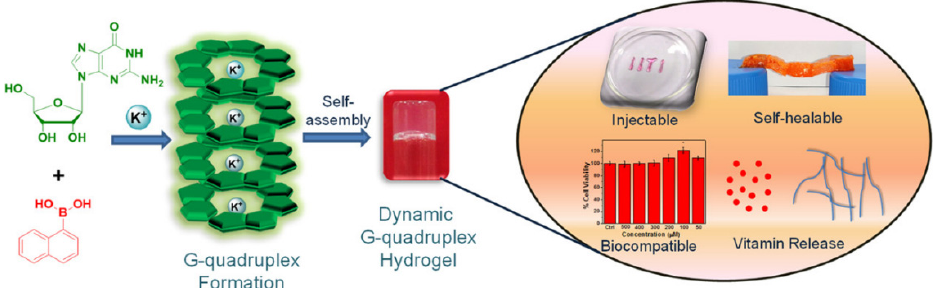
Figure 76. G-Quadruplex formation of a cytidine-based gelator and its features. Reprinted with permission from [138]. Copyright 2020 American Chemical Society.